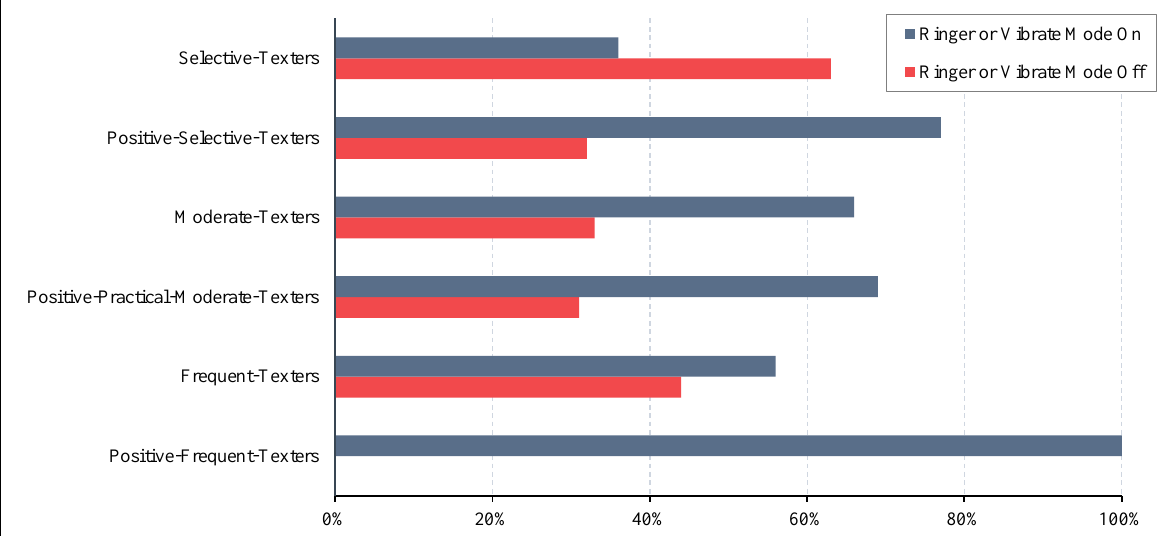
Figure 1. Cell phone mode during homework